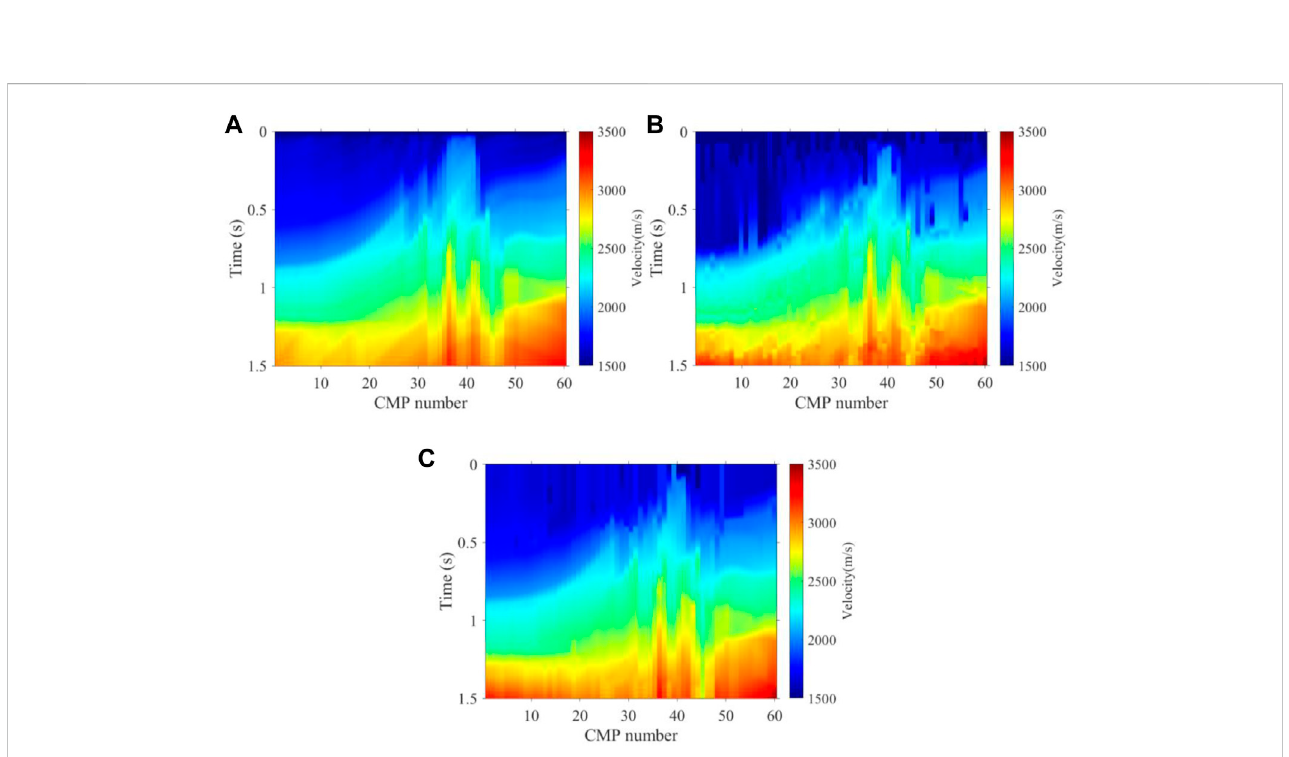
FIGURE 7 Stacking velocity fi eldofsynthetic data without noise. (A) Truevelocity, (B) K-meansintelligentpicking velocity,and (C) intelligentpicking velocitybythe method